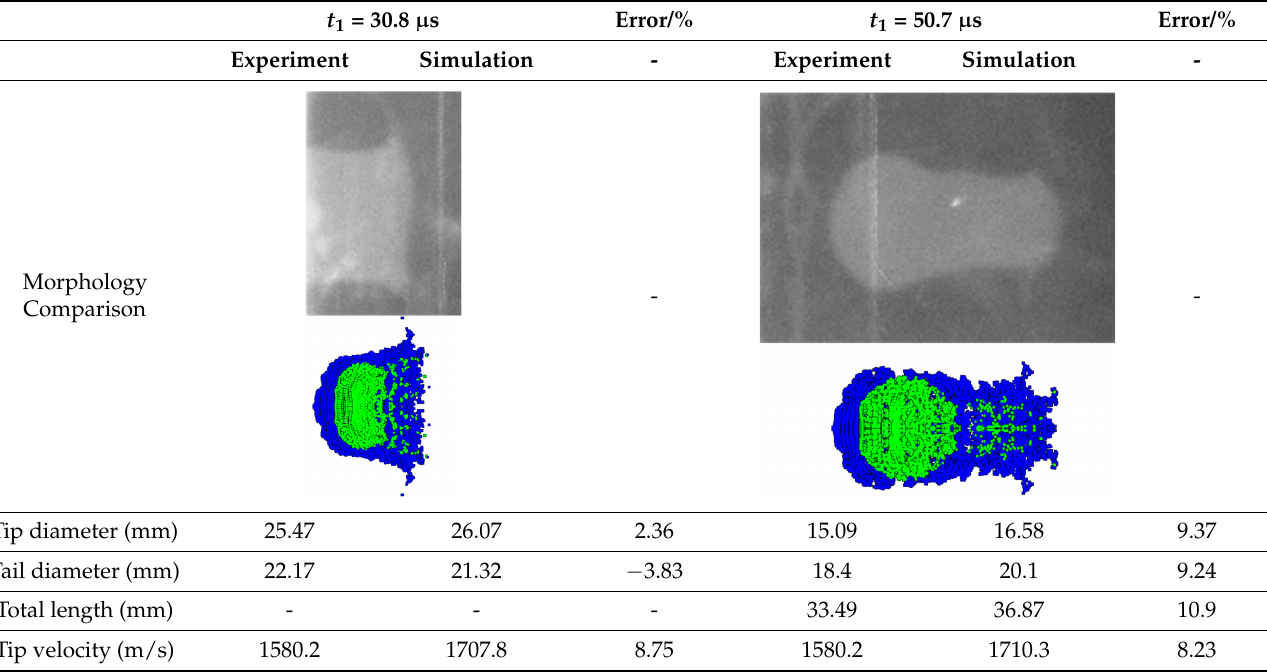
Table 3. Comparison between experiments and simulations.